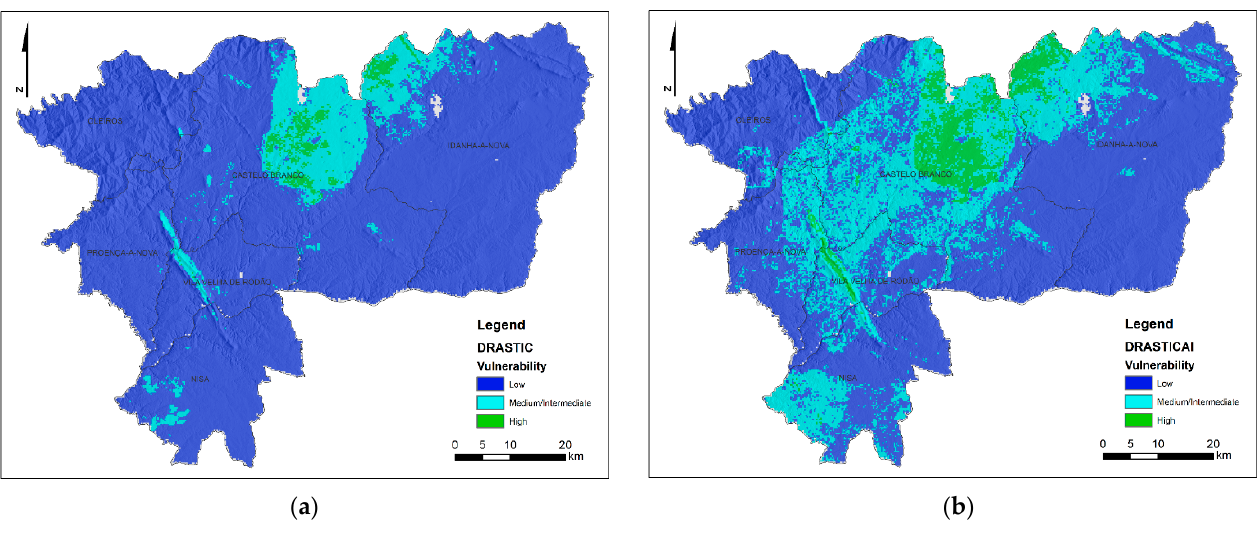
Figure 4. DRASTIC ( a ) and DRASTICAI ( b ) maps.